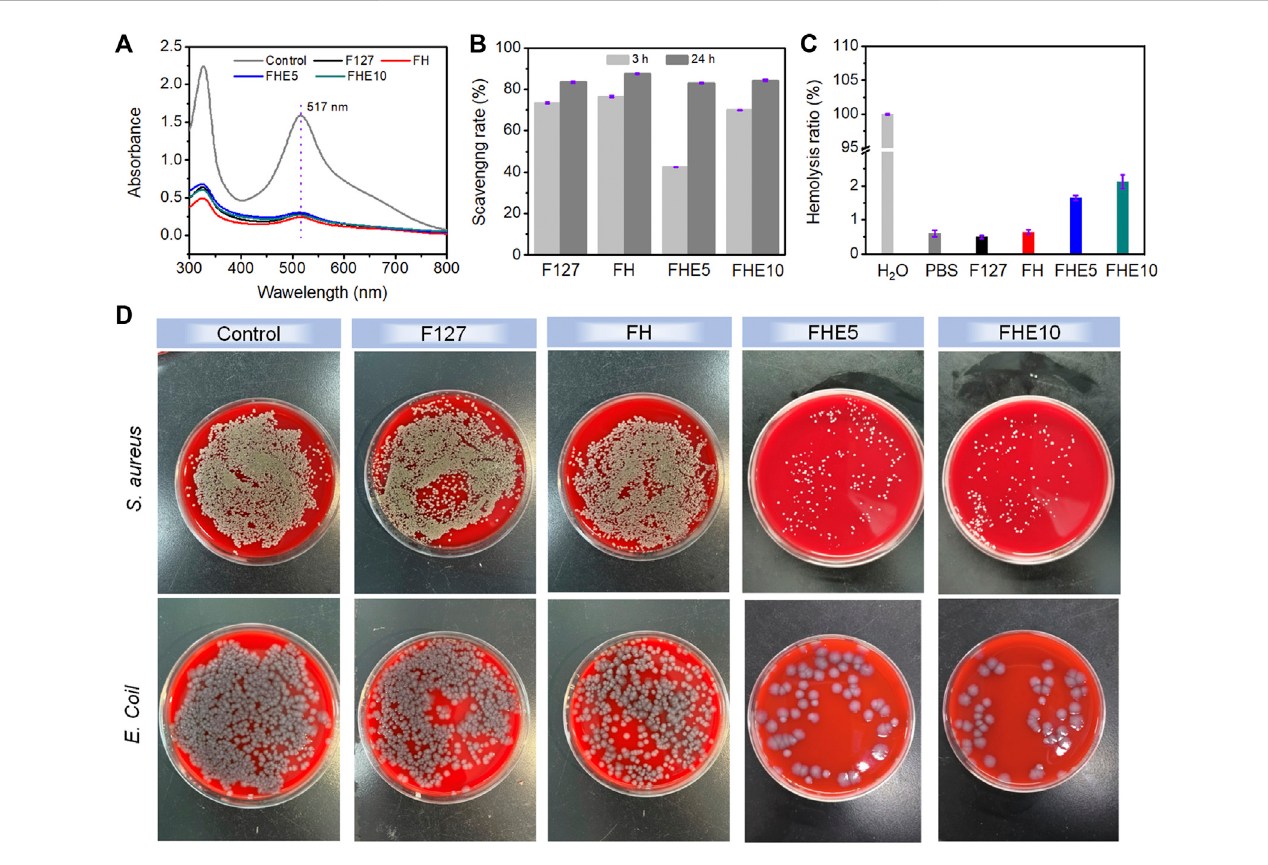
FIGURE 3 (A) UV absorption of DPPH solution after co-incubation with F127, FH, FHE5, and FHE10 hydrogel; (B) Scavenging rate of F127, FH, FHE5, and FHE10 hydrogel; (C) Hemolysis ratio of F127, FH, FHE5, and FHE10 hydrogel; (D) Photographs of survival bacteria clones on SBA plates after coculturing with F127, FH, FHE5, and FHE10